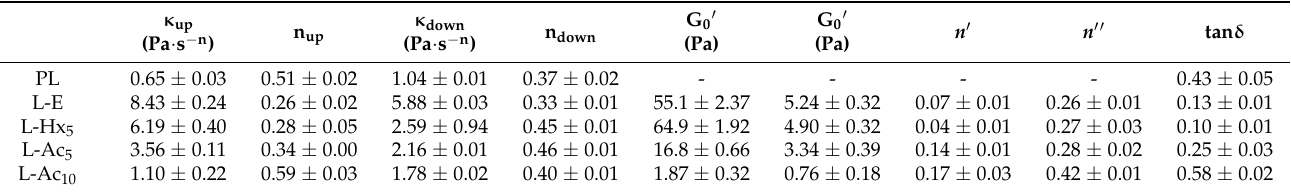
Figure 5. Flow behaviour and viscoelastic properties of emulsions with addition of PL extract or liposomal dispersions. Viscosity vs. shear rate in up ( a ) and down ( b ) curves; elastic modulus G (cid:48) ( c ), and viscous modulus G (cid:48)(cid:48) ( d ) were plotted as a function of frequency. Table 3. Flow and viscoelastic parameters for water-in-oil emulsions stabilized with partially purified phospholipids extract (PL) and liposomal